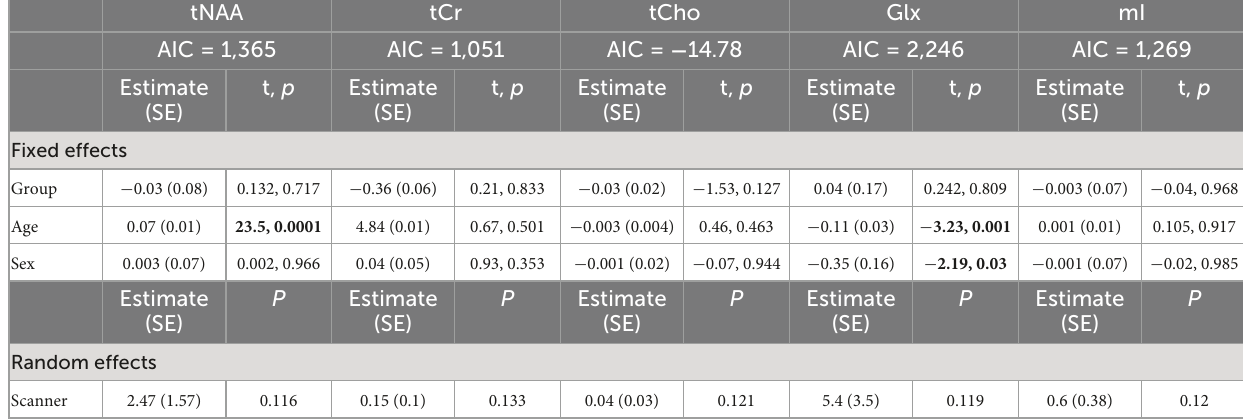
TABLE 5 Details of the linear mixed-effects model with metabolites of interest (tNAA, tCr, tCho, Glx, and mI) as the dependent variable.